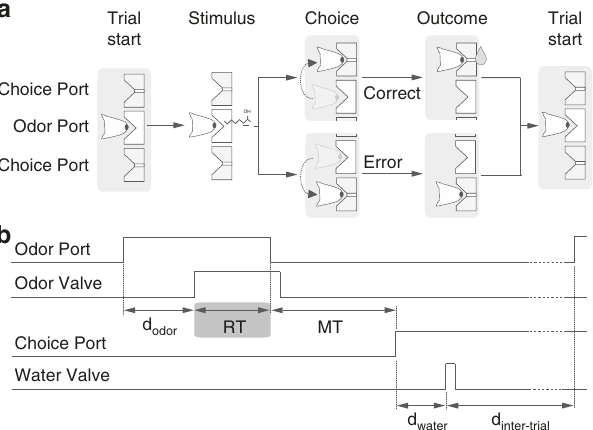
Fig. 1 Two-alternative odor choice task. a Rats were trained in a behavioral box to signal a choice between left and right port after sampling a central odor port. The sequence of events is illustrated using a schematic of the ports and the position of the snout of the rats. b Illustration of the timing of events in a typical trial. Nose port photodiode and valve command signals are shown (thick lines). A trial is initialized after a rat pokes into a central Odor Port. After a randomized delay d odor a pure odor or a mixture of odors is presented, dependent of the task at hand. The rat can sample freely and respond by moving into a choice port in order to get a water reward. Each of these ports is associated to one of two odors — odor A (( R )-( − )-2- octanol) and odor B (( S )-( + )-2-octanol). Highlighted by the gray box, reaction time (RT) is the amount of time the rats spend in the central Odor Port after odor valve is on (i.e. discounting d odor ). See Methods for more